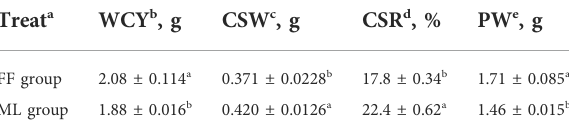
a FFgroup,silkwormsrearedonformulafeed;MLgroup,silkwormsrearedonmulberry leaves. b WCY, whole cocoon yield. c CSW, cocoon shell weight. d CSR, cocoon shell rate. e PW, pupae weight. Data are presented as mean ± standard deviation. Different letters within a column indicate signi fi cant differences between FF and ML groups ( p <